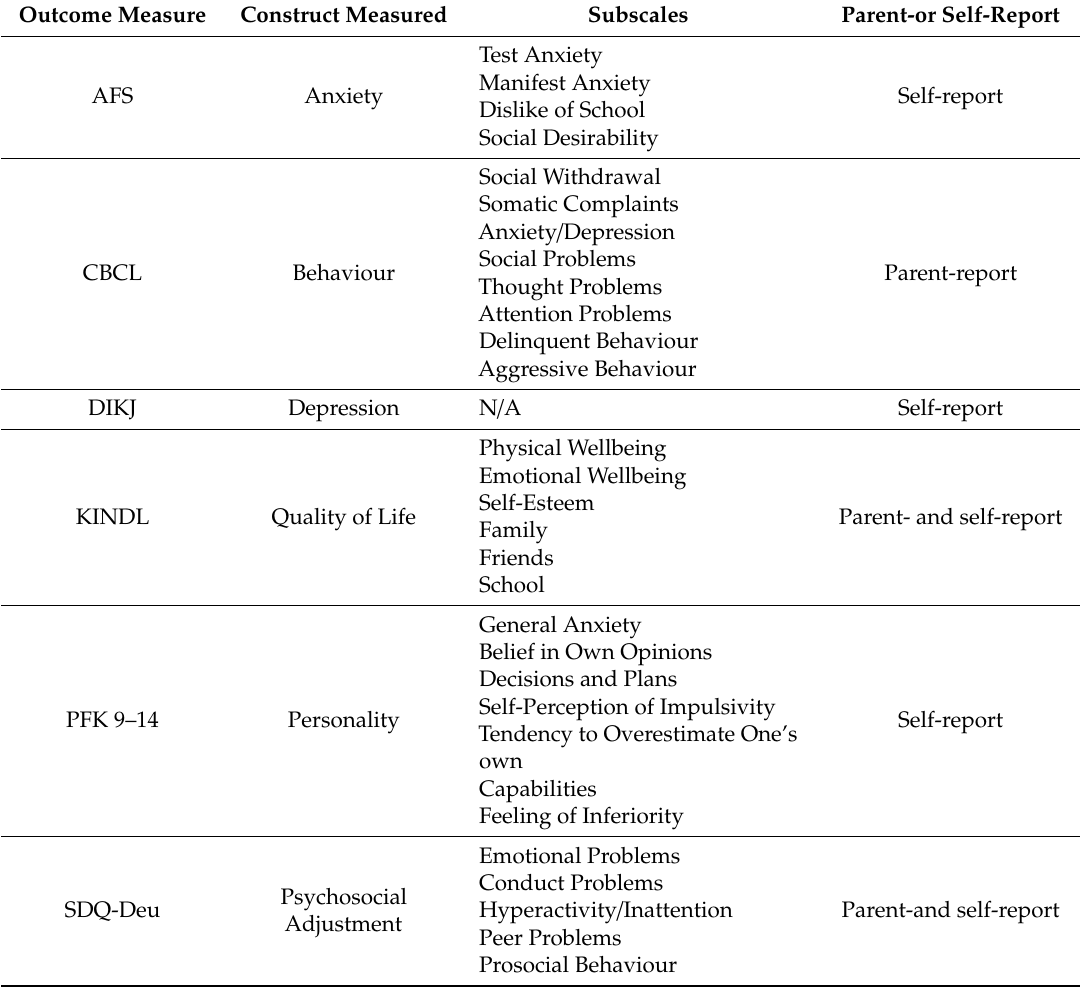
Table 2. Child outcome measures used in included